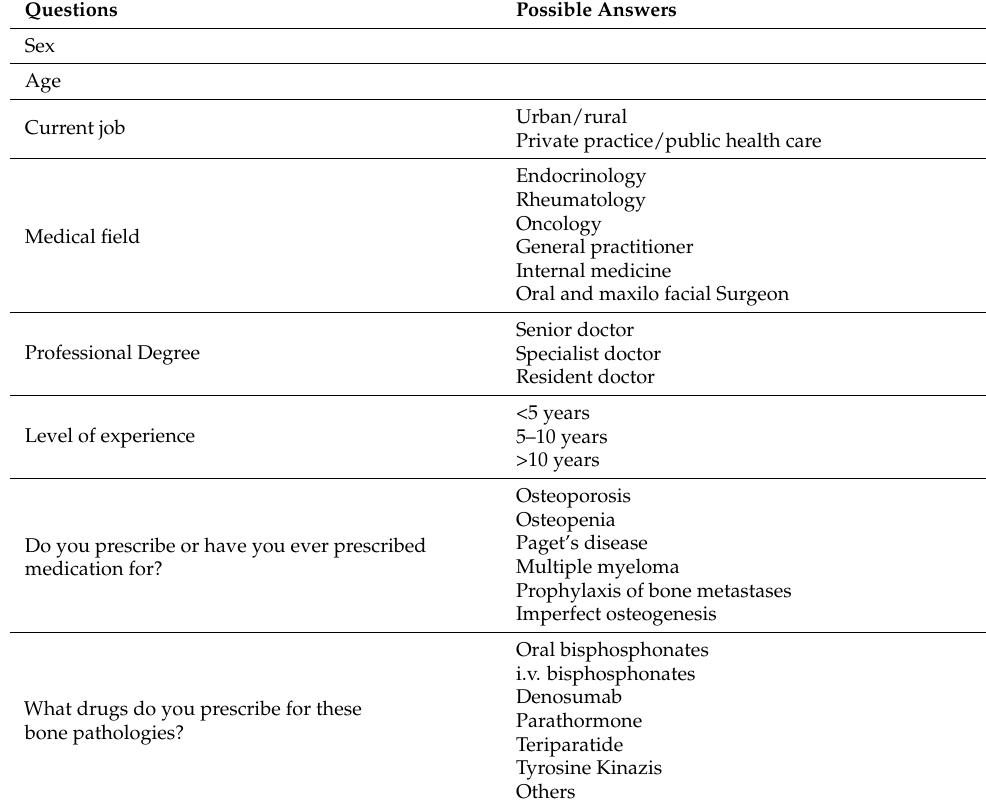
Table 2. Model of the questionnaire